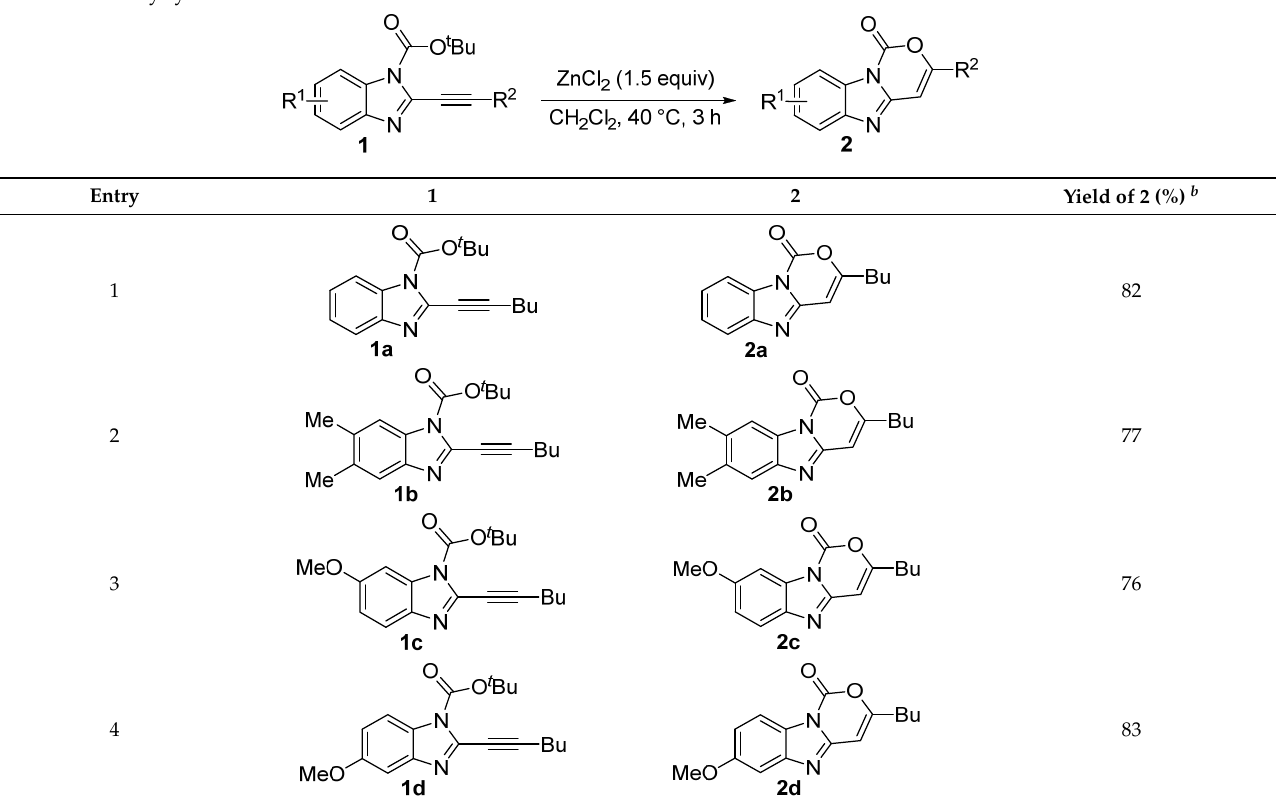
Table 2. Synthesis of 1 H -benzo[4,5]imidazo[1,2- c ][1,3]oxazin-1-ones 2 by ZnCl 2 -promoted deprotective heterocyclization of N -Boc-2-alkynylbenzimidazoles 1 a.